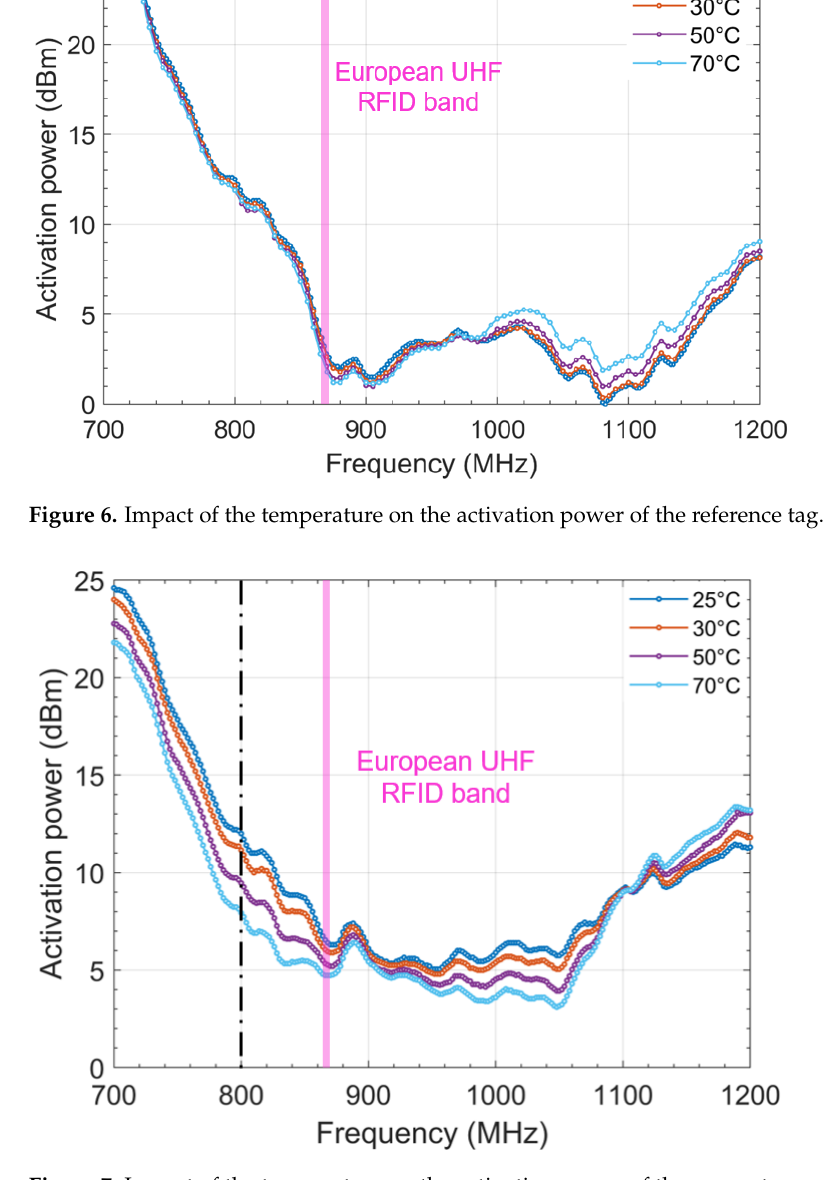
Figure 7. Impact of the temperature on the activation power of the sensor tag.